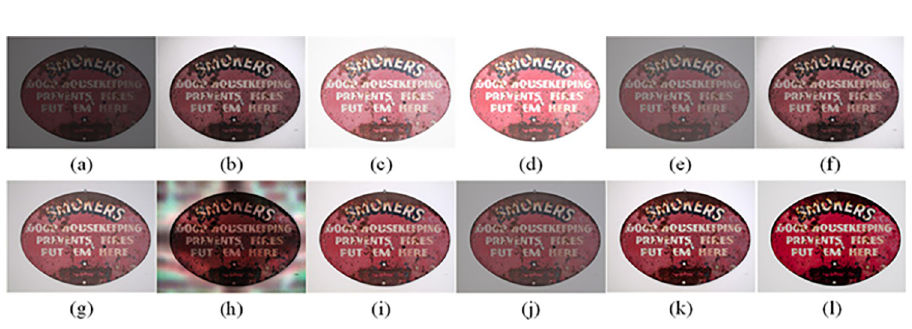
Fig 18. Comparisons of the ten algorithms in enhancing low-light image 8. (a) low-light image (b) AGCWD (c) Al- Ameen (d) BHE2PL (e) BIMEF (f) BPDHE (g) LIME (h) MSRCR (i) NPEA (j) SRIE (k) OURS (l) Normal light image.